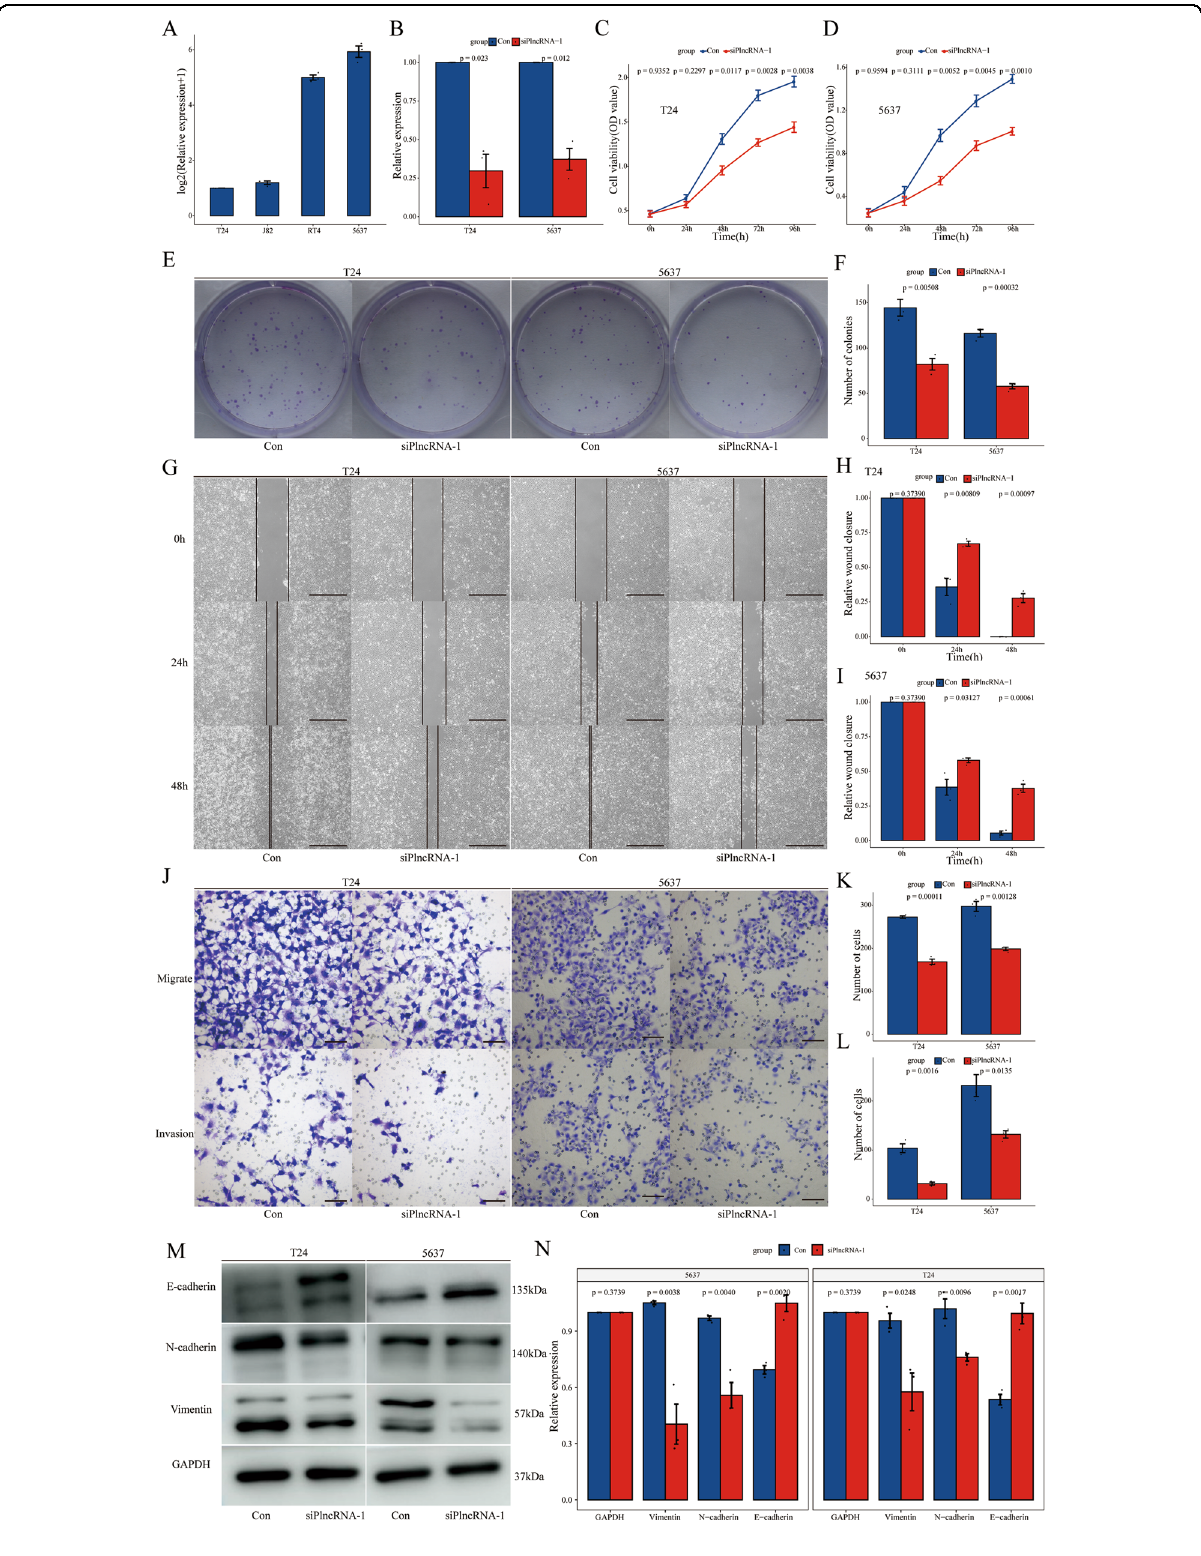
Fig. 2 (See legend on next